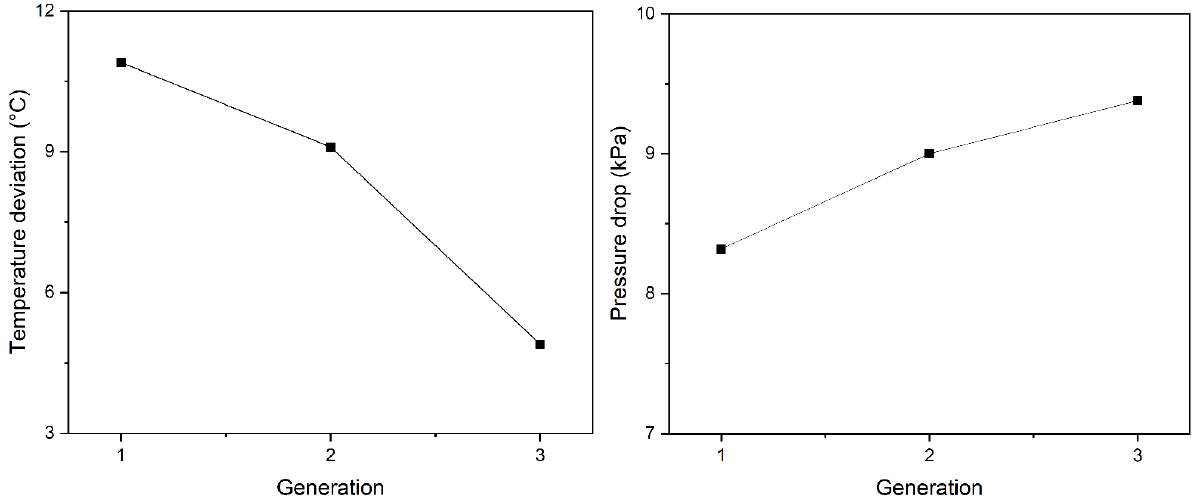
Figure 12. The standard deviation of temperature by generation ( Left ) and pressure drop inside of the cooling channel ( Right ).